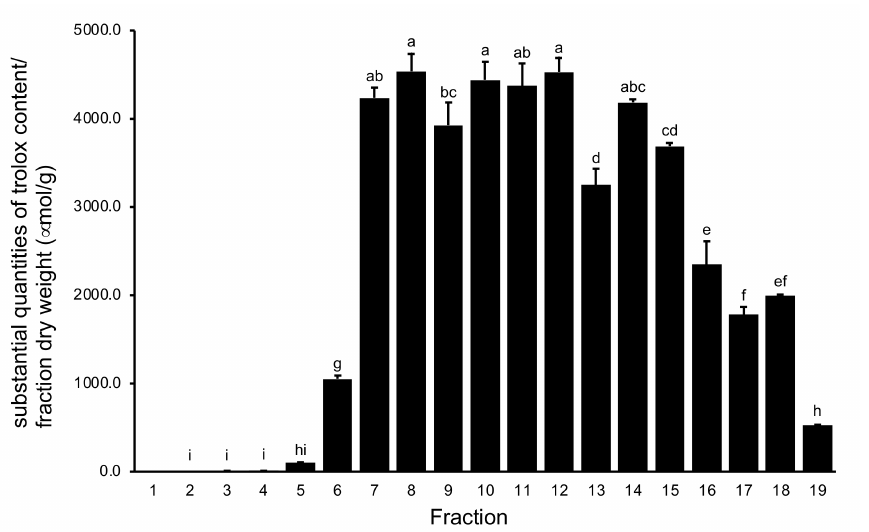
Figure 3. Antioxidant activities of Fractions from Water Extracts of V. virgatum stems. Data are mean ± SD for three independent experiments. Different letters represent significant differences by Tukey’s multiple comparison test ( p = 0.01). Fraction 1 was not detected.